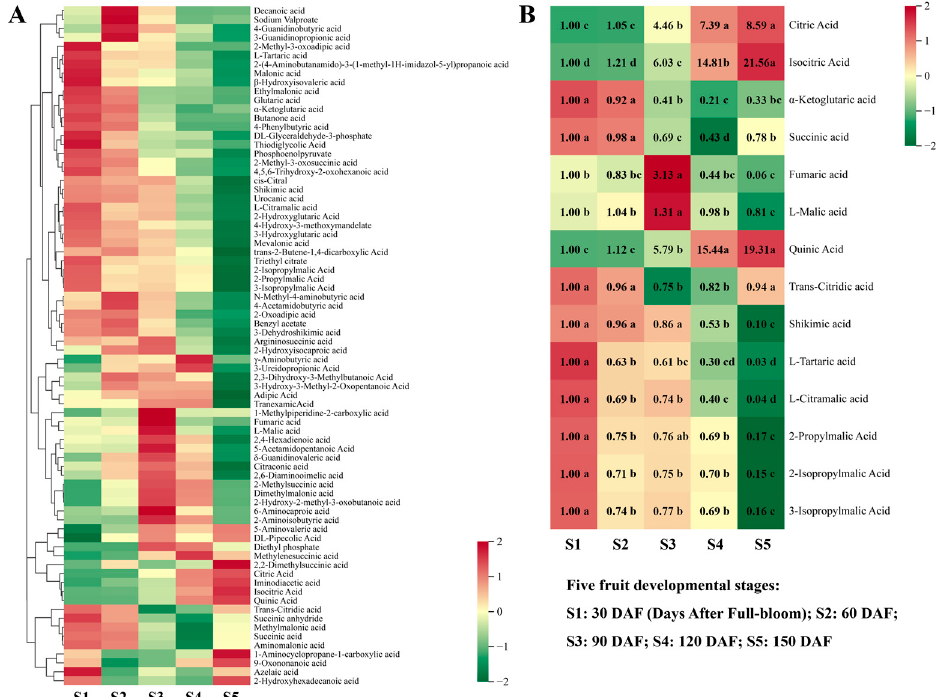
Figure 3. Changes in organic acid metabolism among the five developmental stages of fruit. ( A ) Heat map of the metabolism of 76 organic acids; ( B ) heat map and differential fold changes in the metabolism of 14 representative organic acids. The first period of 30 days after full-bloom (DAF) was used as a calibration value to calculate metabolite ploidy across the five periods. Significance analysis was performed using SPSS software with Tukey’s test and using a threshold of p < 0.05; the results are indicated by lowercase letters a, b, c, d, and e in the figure. Different letters indicate different levels of significance for comparisons between two samples. Different colors on the heat map indicate the proportional contents of each metabolite, as determined based on the mean peak response area normalized to an R scale. Three independent biological replicates were assessed for each